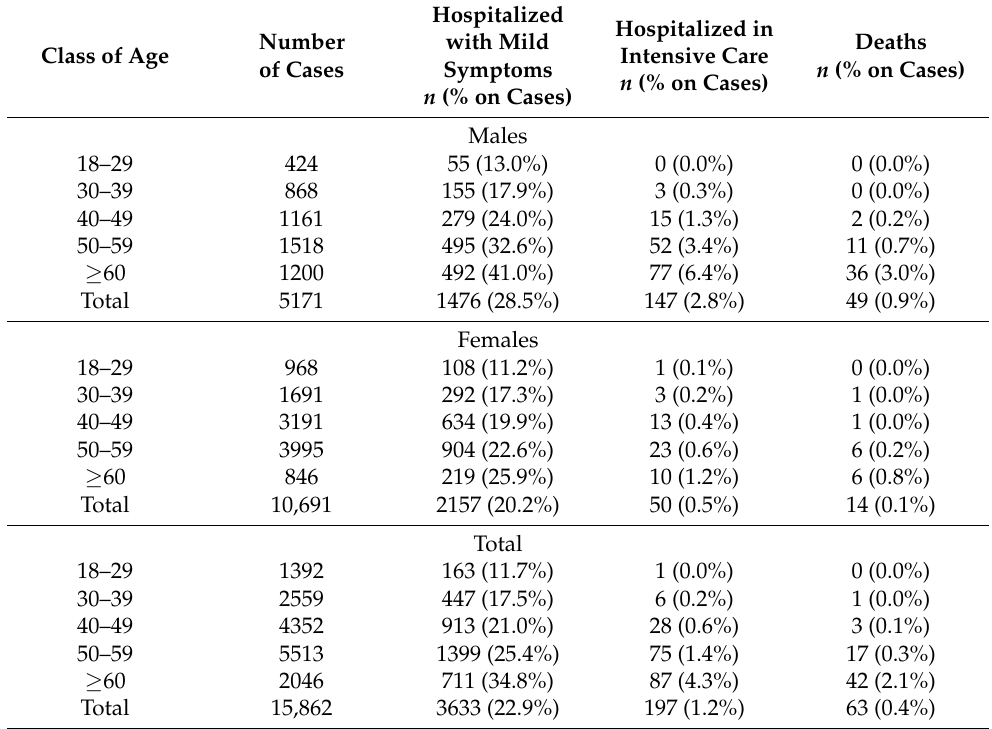
Table 3. The number of total cases and percentages of HCWs hospitalized with mild symptoms, hospitalized in intensive care and deaths in total cases, by gender and class of age.